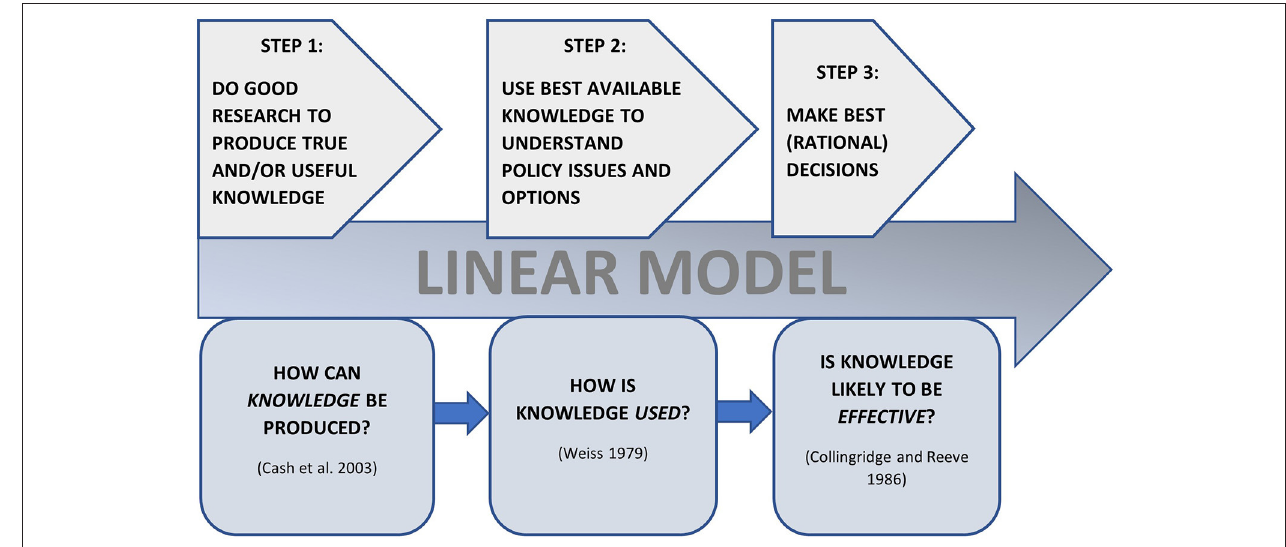
FIGURE 2 | The linear model as a conceptual aid to understanding political influences in evidence development and